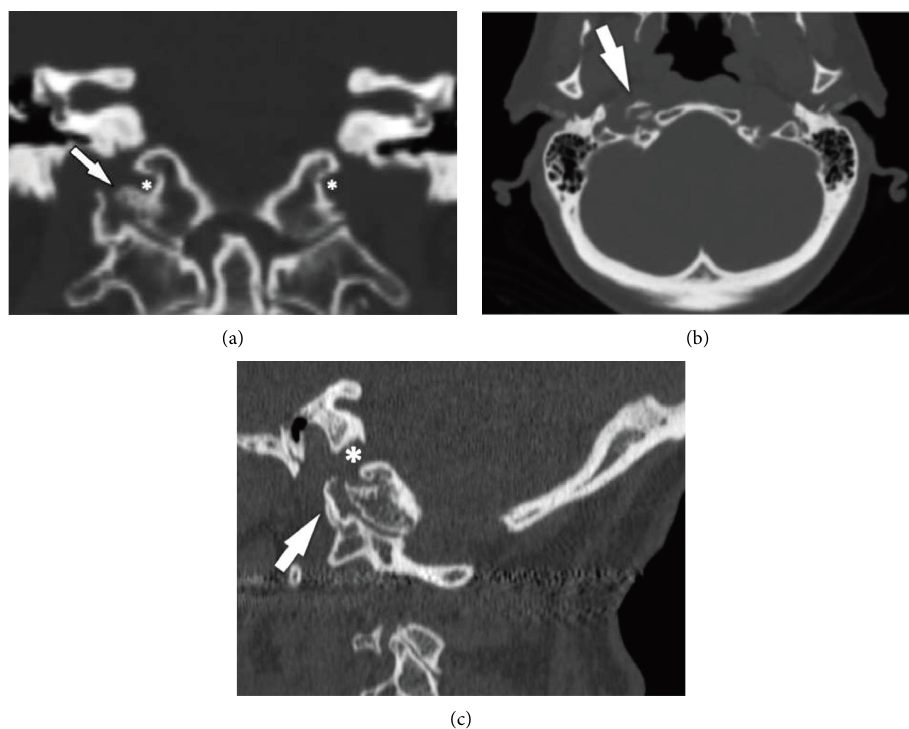
Figure 1: (a) Coronal reformatted CT image shows osteophytosis (arrow) of the atlanto-occipital articulation on the right. Te osteophyte arising from the occipital condyle narrows the hypoglossal canal (asterisks). (b) Axial CTshowing osteophyte in the right hypoglossal canal. (c) Sagittal CT showing osteophyte in the right hypoglossal canal.